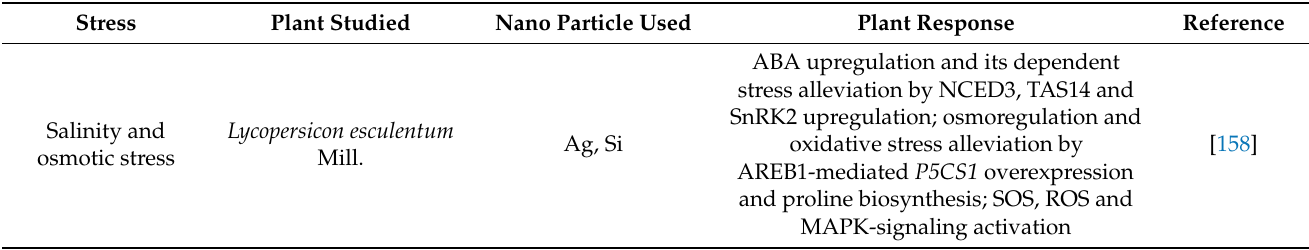
Table 4. Molecular responses under the influence of